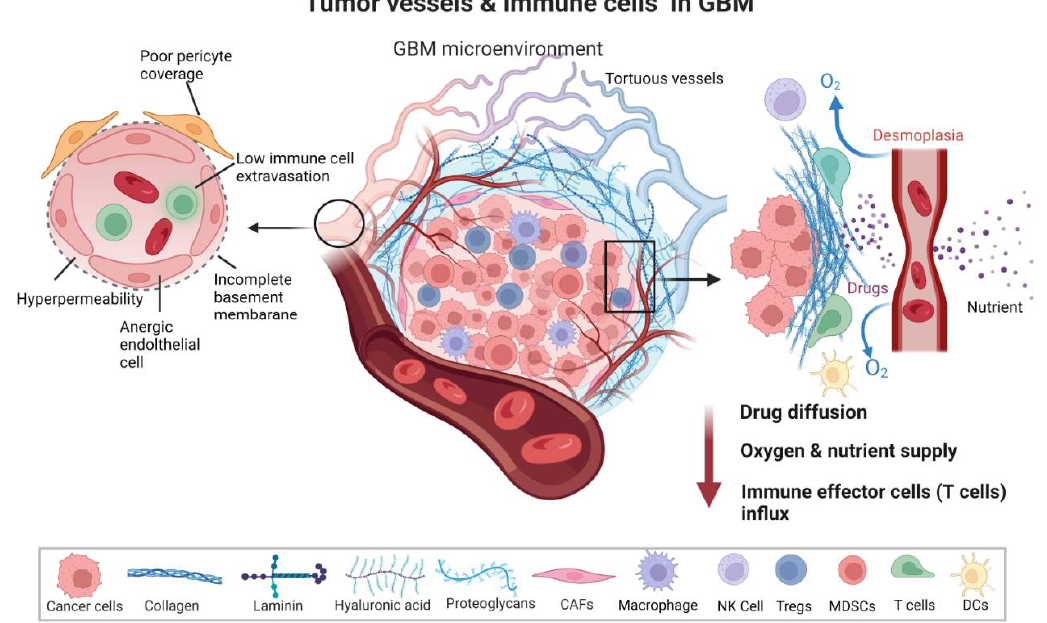
Figure 1. Tumor vessels and immune cells in Glioblastoma (GBM). The tumor microenvironment of GBM is characterized by erratic, tortuous vessels that have anergic endothelial cells, poor pericyte coverage and incomplete basal membrane. The vessels are therefore hyperpermeable and leaky, subsequently restricting immune cell extravasation. There is intricate relation of blood vessels with recruitment of immune cells to tumor; as the extra cellular matrix components (collagen, laminin, hyaluronic acid, proteoglycans) of tumor and desmoplastic tumor vessels orchestrate a barrier for effector immune cells influx, drug delivery and mediated with reduced oxygen and nutrient supply. T effector cells, natural killer (NK) cells, dendritic cells (DCs) are restricted from entry to tumor niche, which is replete with T regulatory cells (Tregs), myeloid derived suppressor cells (MDSCs), cancer-associated fibroblasts CAFs-, and glioma associated M2 macrophages. Circle area of the blood vessel is projected to details of the vessel. Rectangle area depicted in details the barrier (of vessels and endothelial cell matrix) where drugs, immune cells and oxygen supply is hindered to the tumor cell, and hence red arrow shows decrease in these parameters at tumor core. Created with BioRender.com.